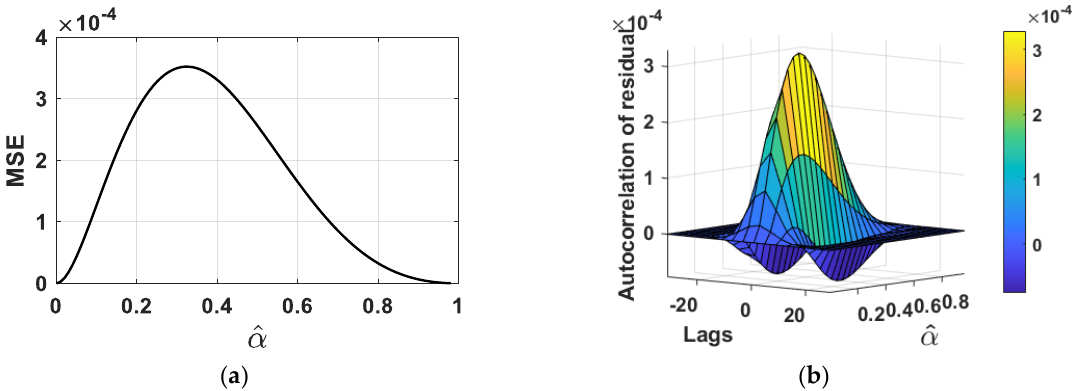
Figure 6. Mean squared error calculated from simulations using a b values span between 1 and 20 and uniformly spaced by 1, and D se = 1/ b max . ( a ) MSE as a function of ˆ α ; ( b ) Autocorrelation of fit error at various lags and ˆ α .